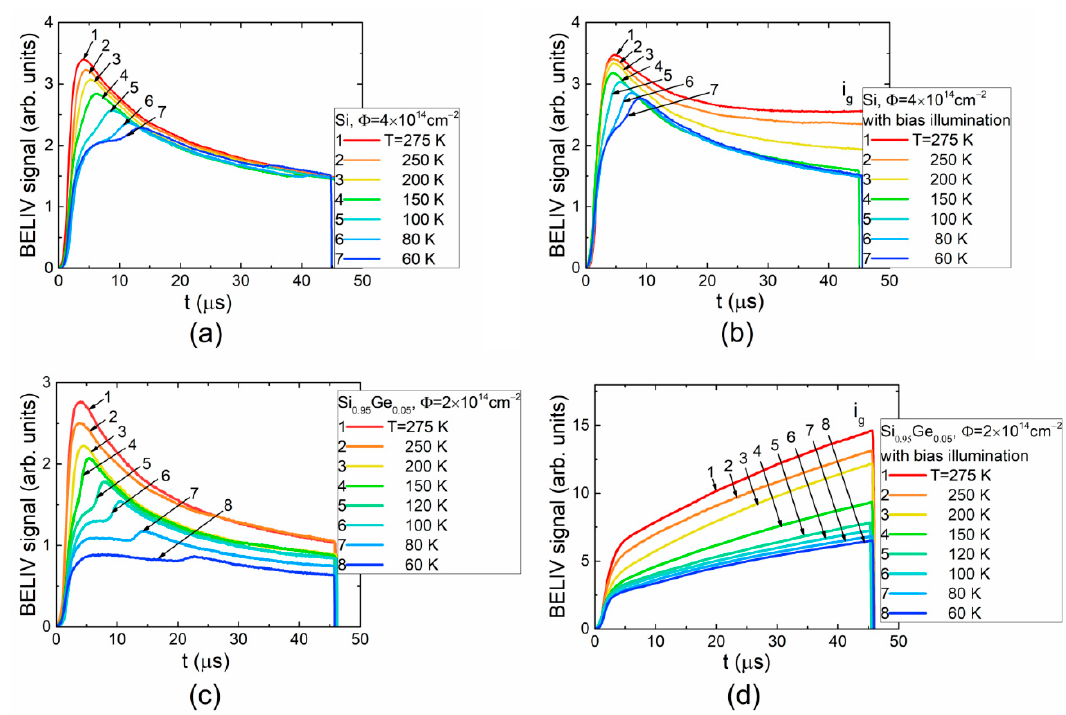
Figure 3. ( a – d ) Temperature-dependent BELIV transients in Si and Si 1 − x Ge x diodes measured in dark ( a , c ) and under ( b , d ) laser illumination.